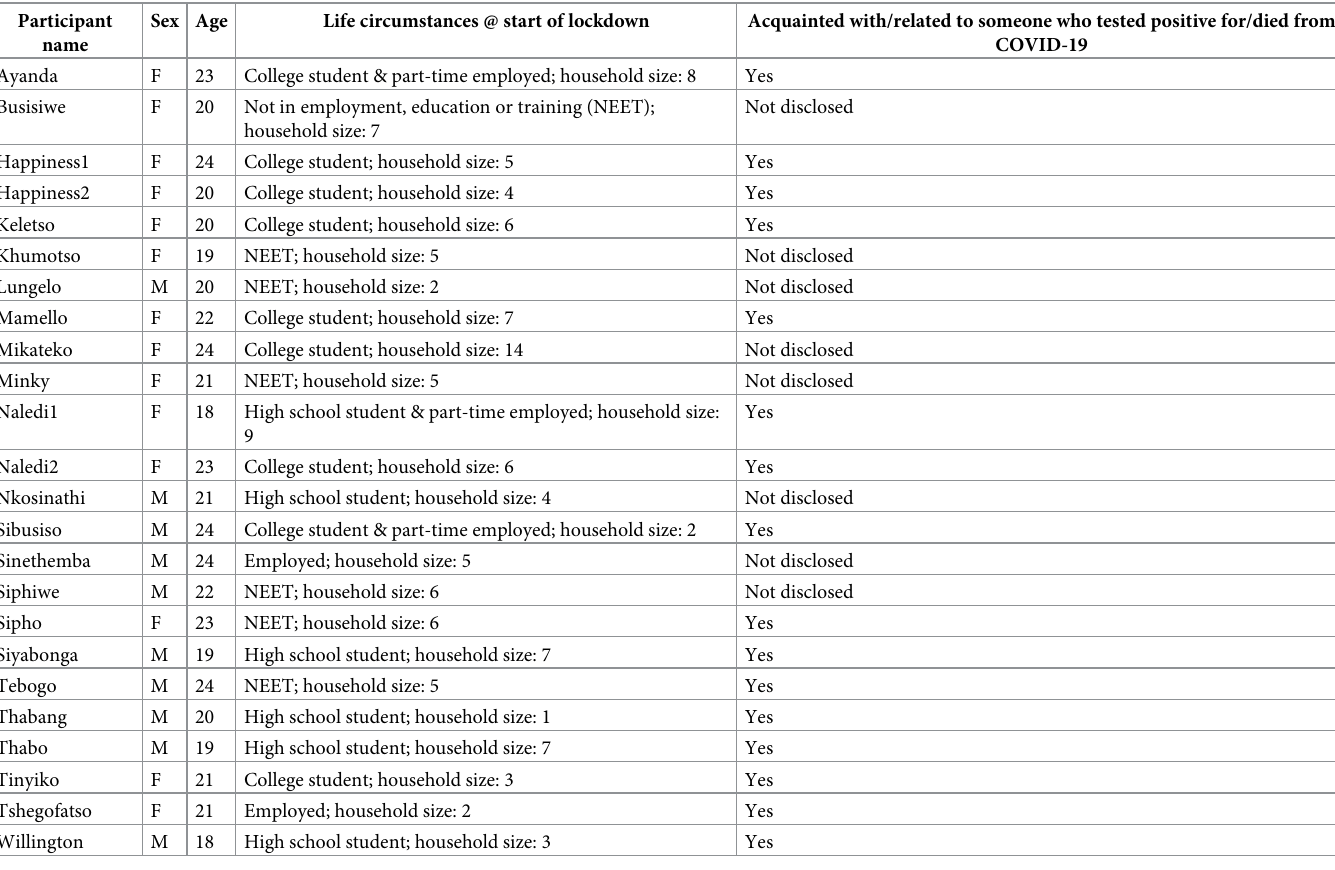
Table 1. Details of the